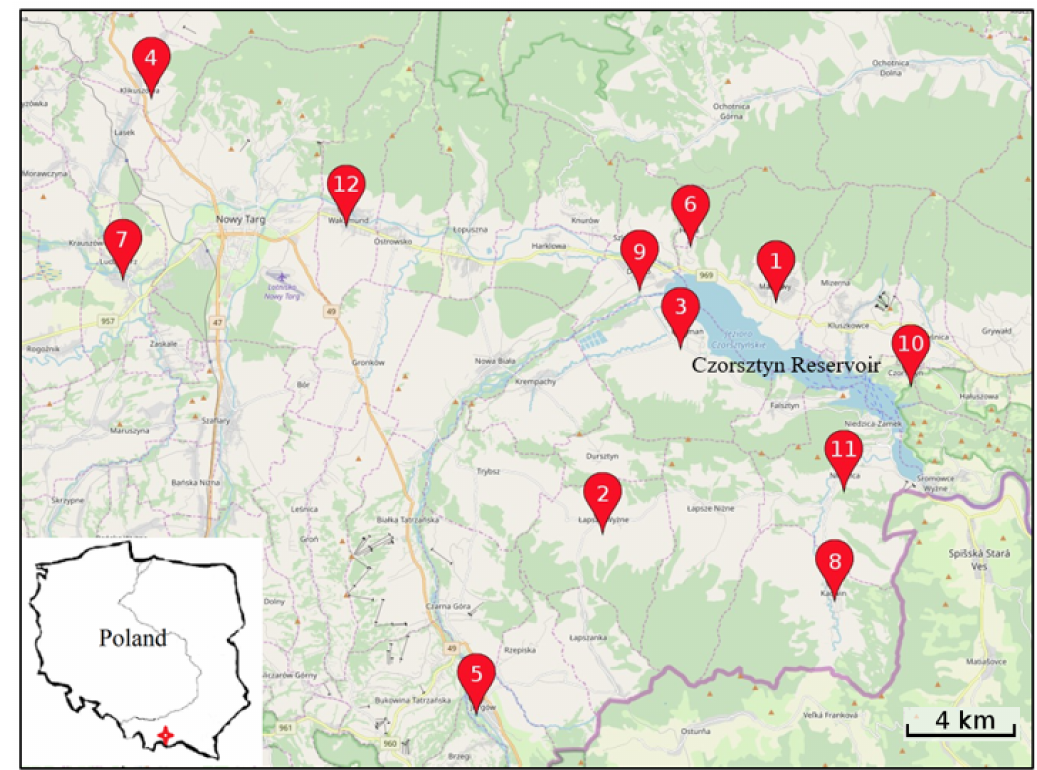
Figure 2. Air measurement sites in the villages surrounding the Czorsztyn Reservoir (modified after [31]); 1—Maniowy, 2— Łapsze Wy˙zne, 3—Frydman, 4—Klikuszowa, 5—Jurgów, 6—Huba, 7—Lud´zmierz, 8—Kacwin, 9—D˛ebno, 10—Czorsztyn, 11—Niedzica, 12—Waksmund. The base map originates from the